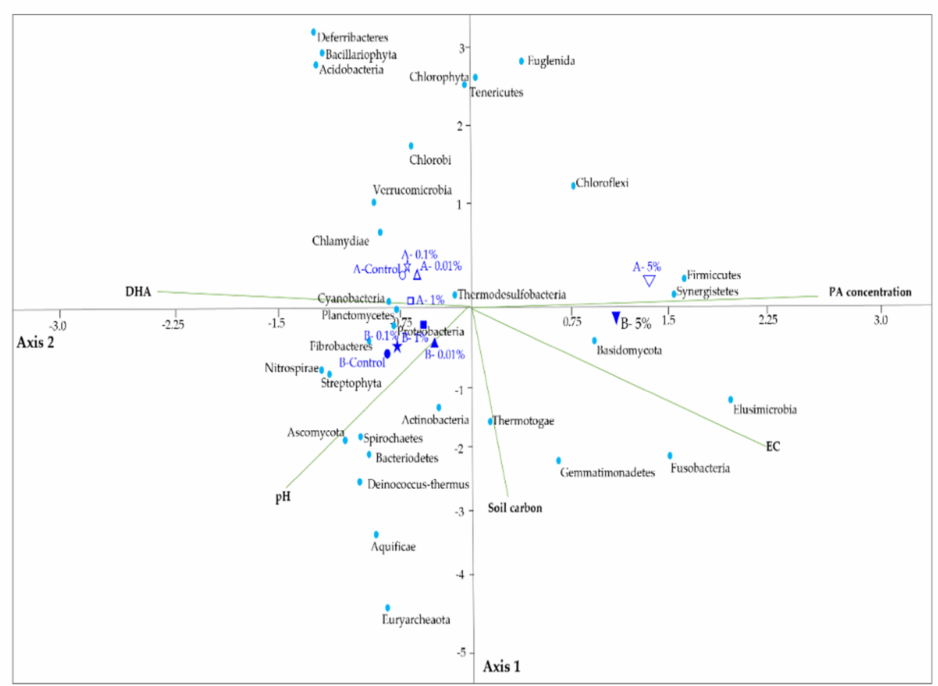
Figure 5. Canonical correspondence analysis (CCA) correlating environmental factors and bacterial phylum of all samples (Circle: control group, triangle: 0.01%, star: 0.1%, square: 1%, and inverted triangle: 5%). Axis1 eigen value 0.54 (85.65%), p = 0.004; Axis 2 eigen value 0.08 (12.54%), p =